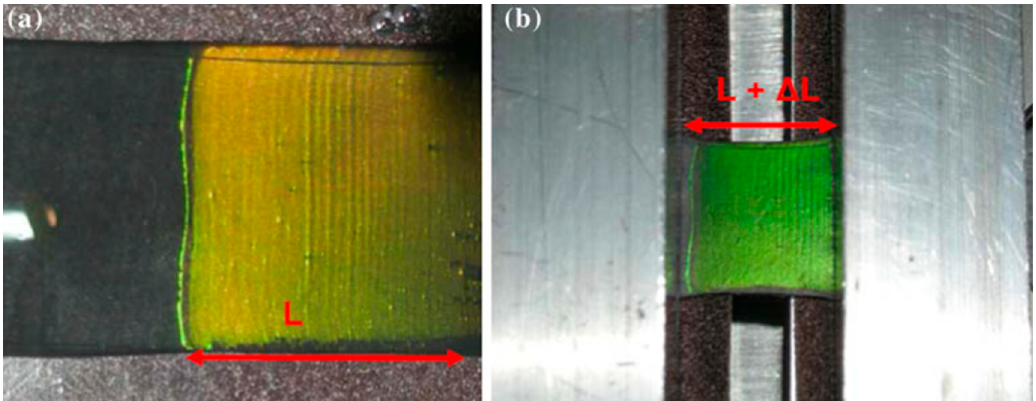
Figure 13. Observed changes in the structural color of the colloidal crystal film deposited on a Viton substrate (1.6 × 1.6 cm 2 ). ( a ) Photo of the initial sheet (length L); ( b ) photo of the stretched sheet (L + DL; DL = 2 mm). Reproduced with permission from [113].